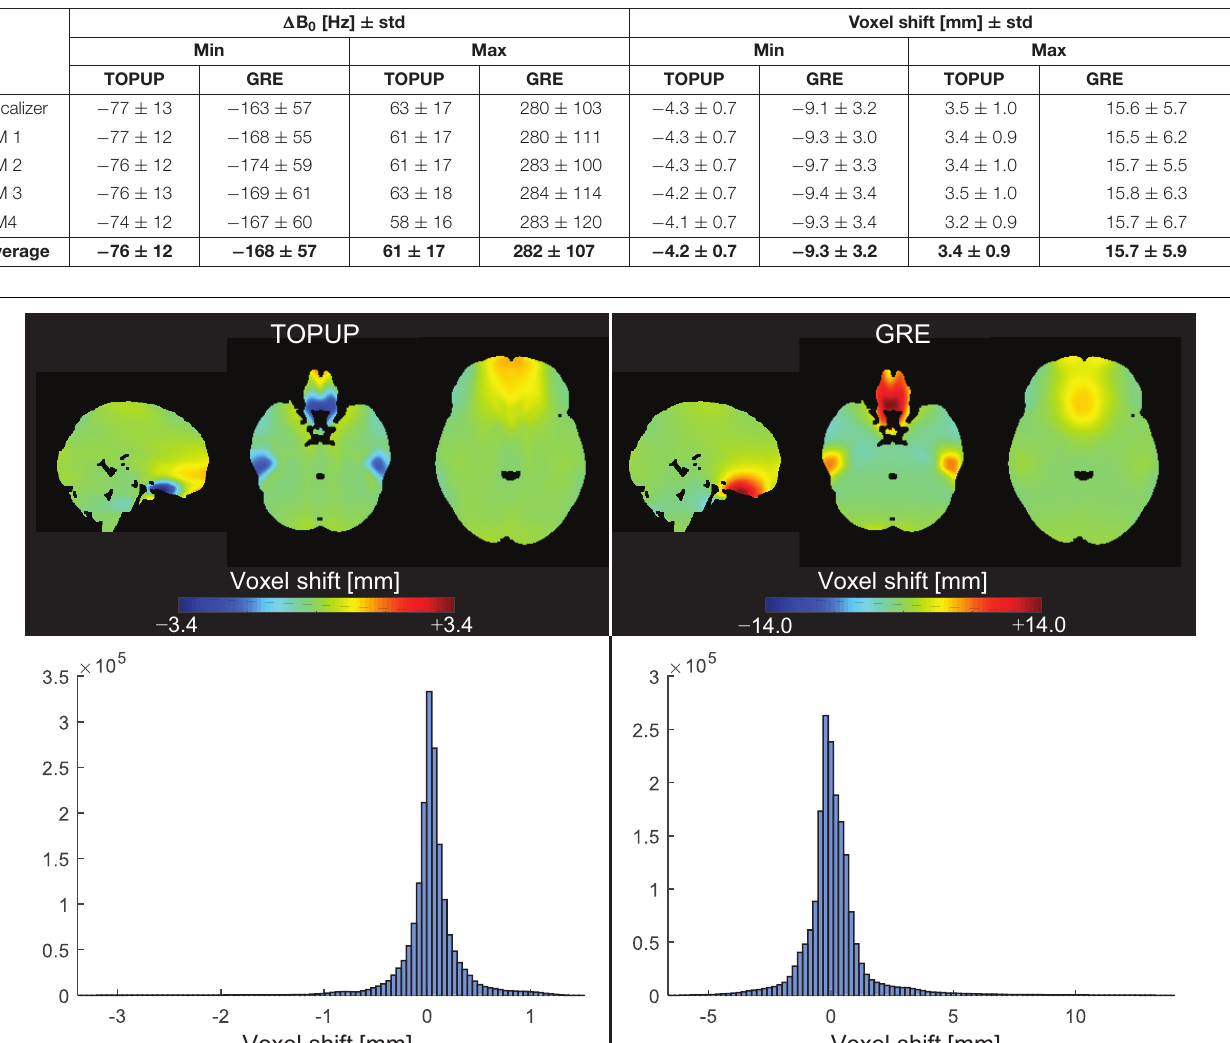
TABLE 1 | Range (minimum and maximum) of (cid:49) B 0 (in Hz) and voxel shift (in mm) in the phase-encoding direction, averaged across voxels and participants, and across runs.